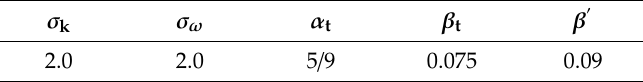
Table 2. Standard k– ω model parameters.